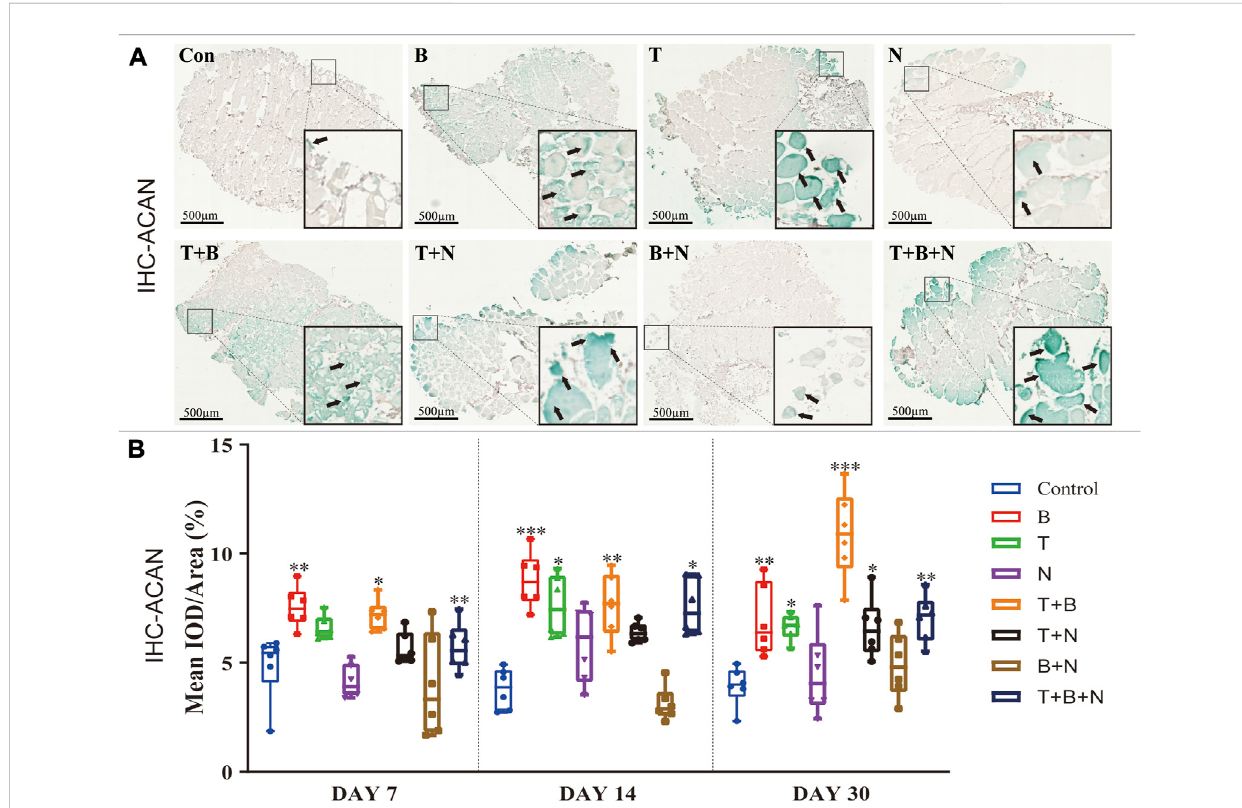
FIGURE 3 The staining results of ACAN antigen in IHC in each group. (A) Staining results on day 30; the positive staining color was green (marked by black arrows). (B) Histomorphometrical assessment; the result was shown as Mean IOD/Area. Control group vs. stimulated groups at 7, 14, and 30 days; the asterisks indicate that the stimulated group is statistically signi fi cant compared to the control group. (Magni fi cation: ×40; n = 6; * p < 0.05; ** p < 0.01; *** p < 0.001).